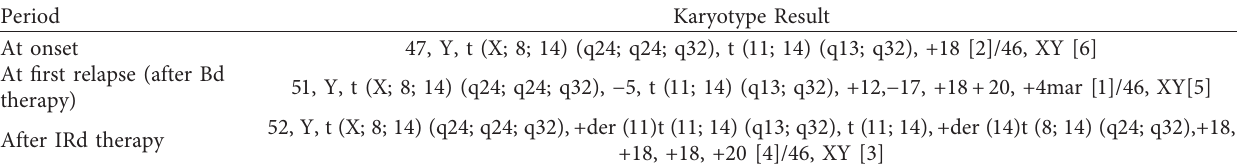
Table 1: Development of cytogenetic aberrations over time during